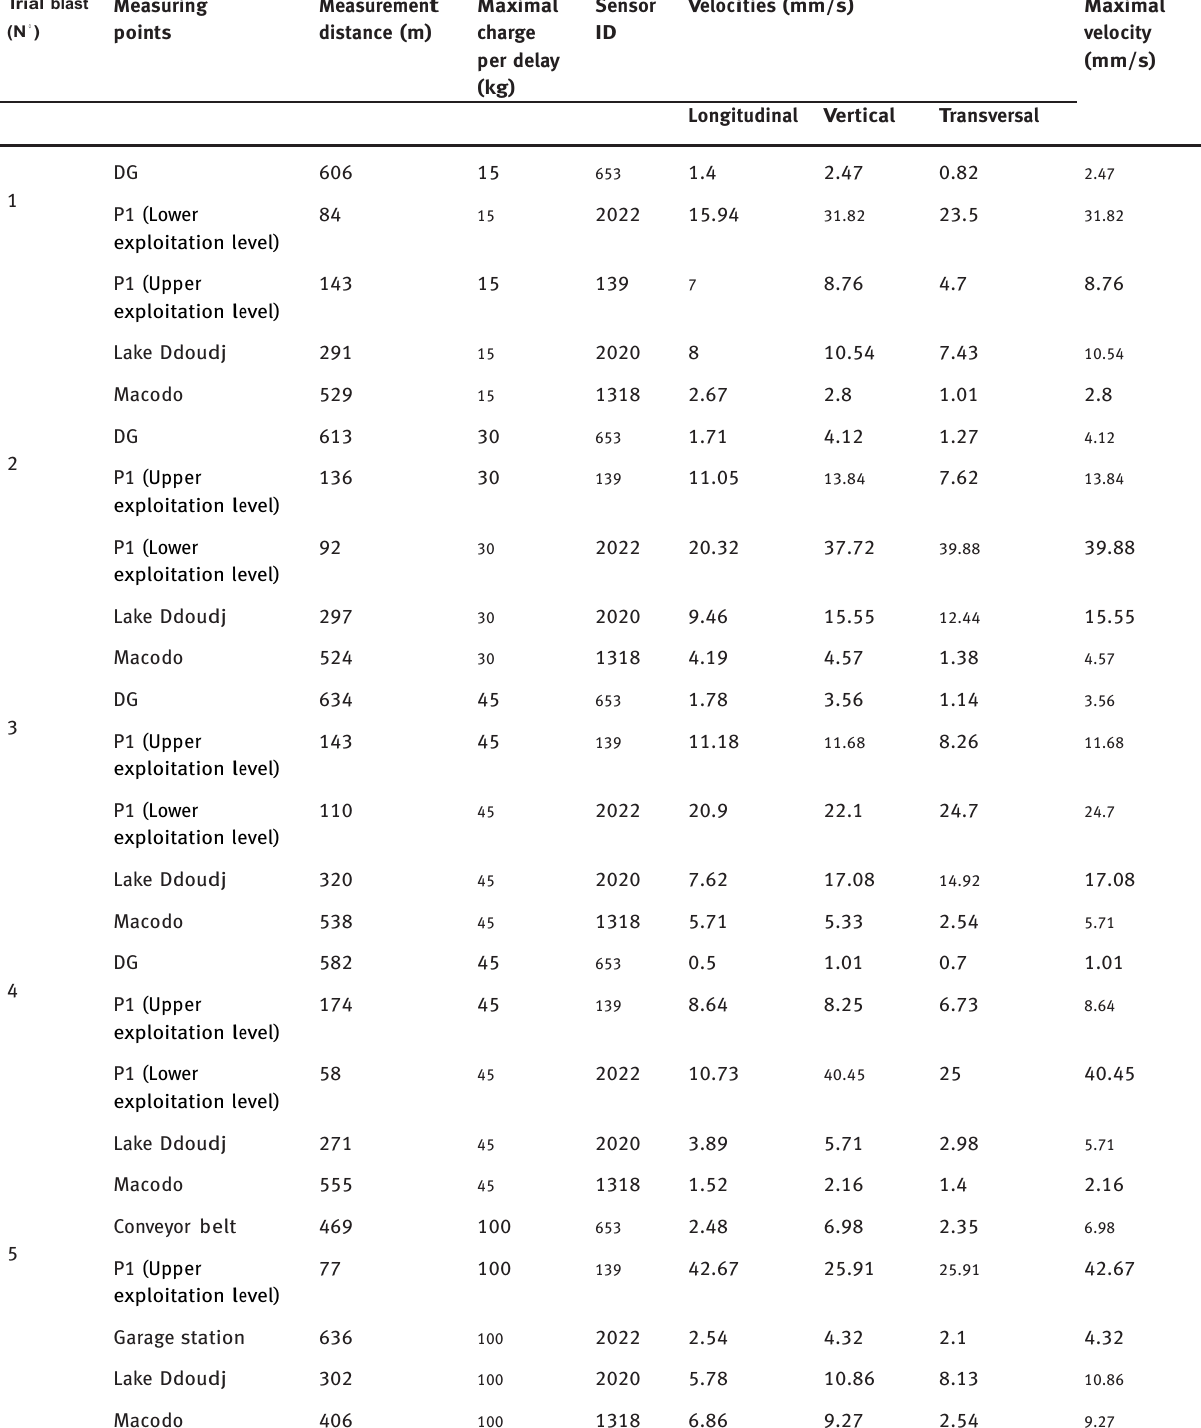
Table 4: Trial blast experiments (from T B 1 to T B 13 ) and the recording of data (velocity components and maximal velocity). Trial